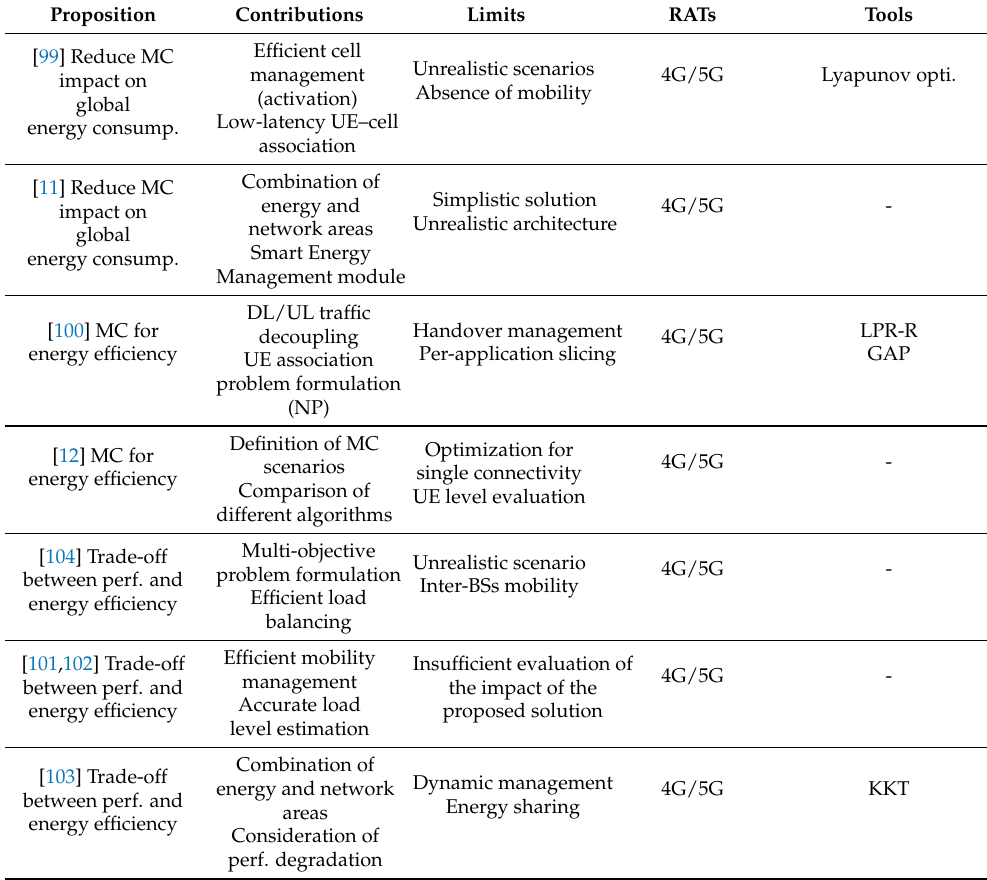
Table 4. Comparison of existing solutions to improve energy